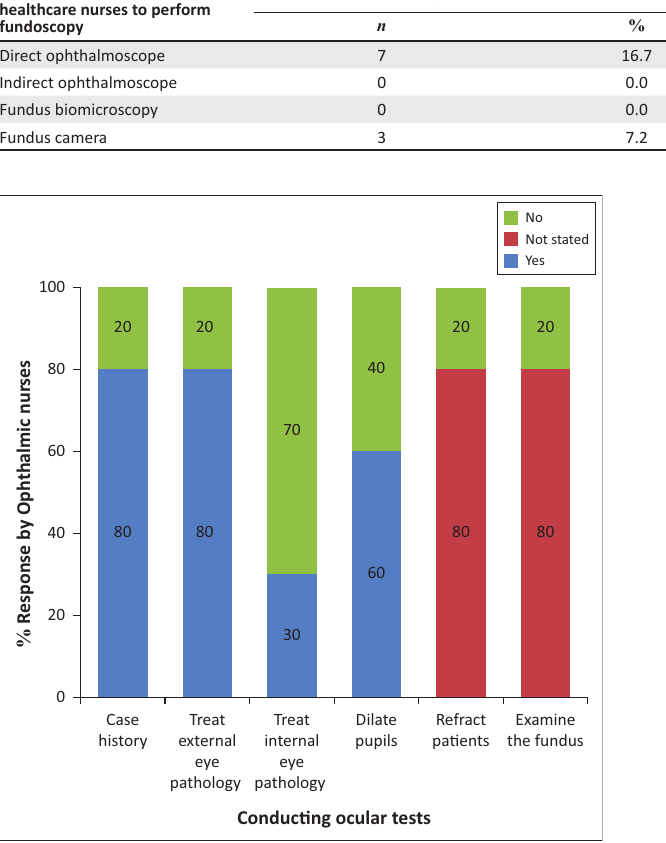
FIGURE 4: Percentage distribution of the role of ophthalmic nurses in conducting ocular tests.